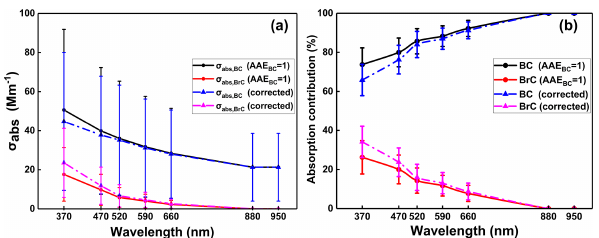
Figure 2. (a) BC and BrC particle average light absorption coef- ficients at different wavelengths under different AAE BC assump- tions; the whiskers represent an error of 1 standard deviation. (b) Contributions of BC and BrC to the total light absorption coeffi- cient at different wavelengths under different AAE BC assumptions; the whiskers represent an error of 1 standard